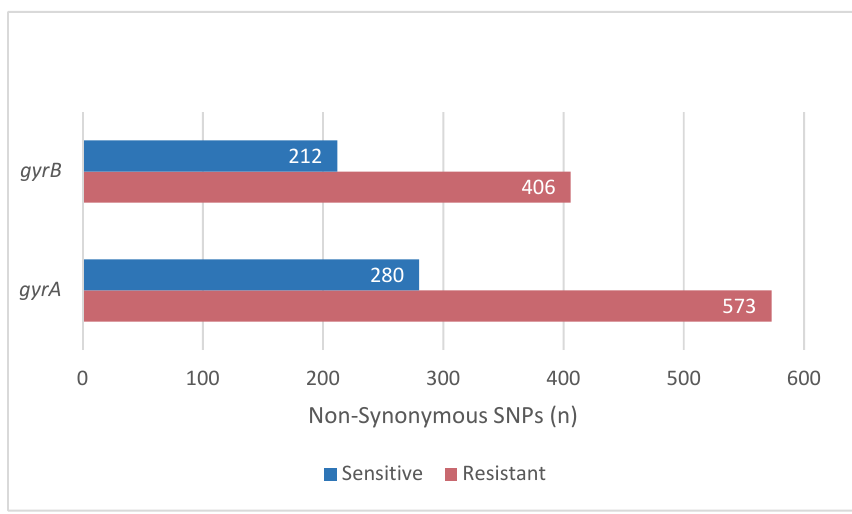
Figure 2. The SNPs obtained after the alignment to the gyrA and gyrB genes of H. pylori strain 26695.